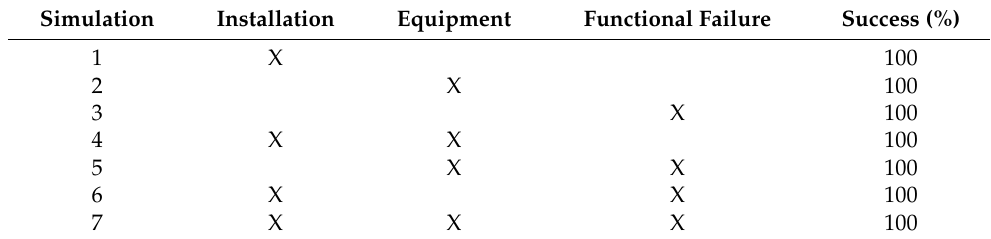
Table 3. Simulations carried out for the validation of the AIRCM application.